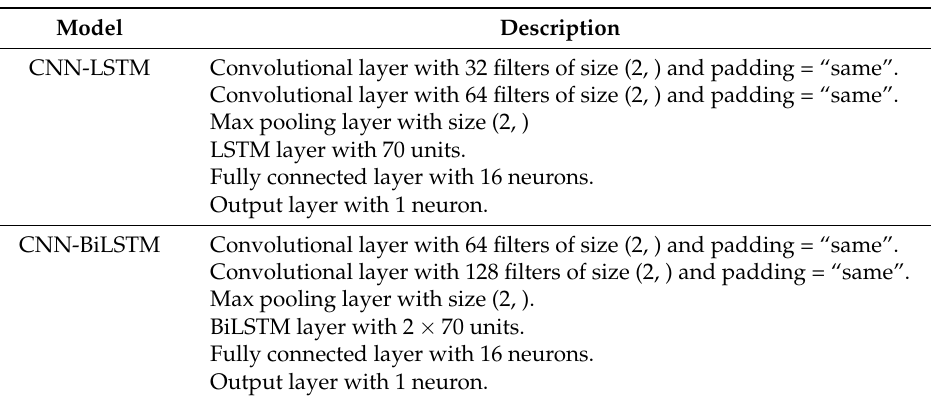
Table 1. Parameter specification of two base learners.